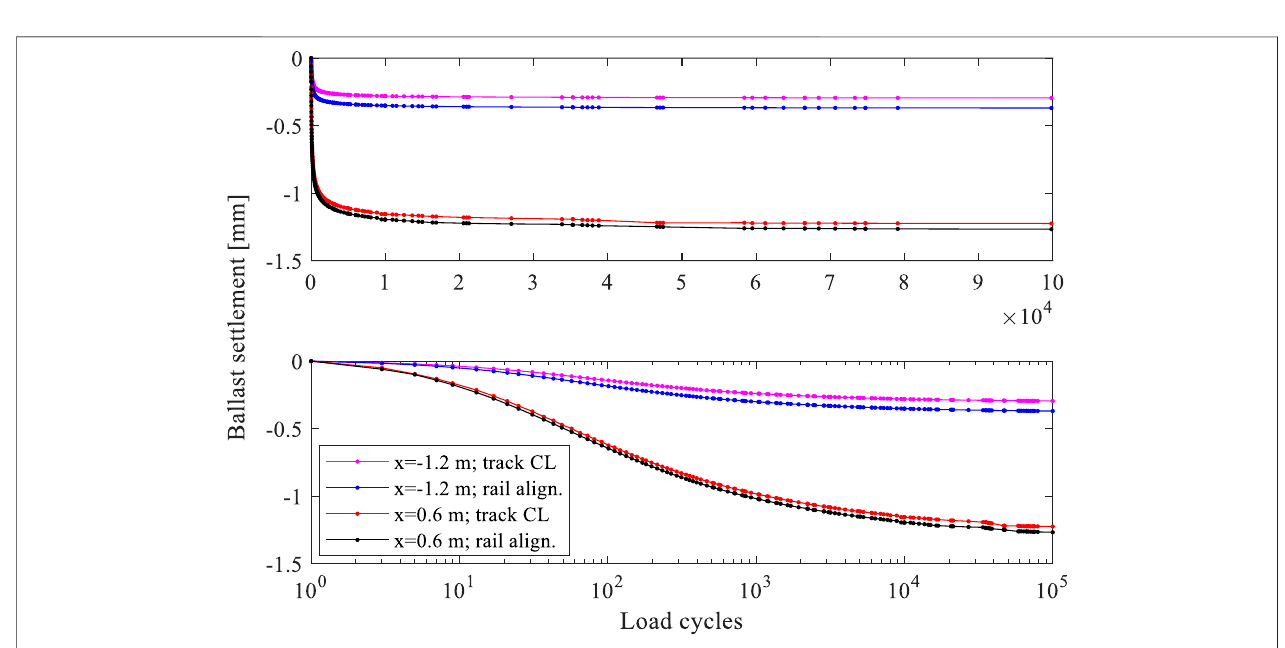
FIGURE 7 | Evolution of the ballast settlement with N, under the sleepers at positions x (cid:1) − 1 . 2m and x (cid:1) 0 . 6m at the track center line (CL; y (cid:1) 0m) and under the rail alignment ( y (cid:1) 0 . 75m), respectively.